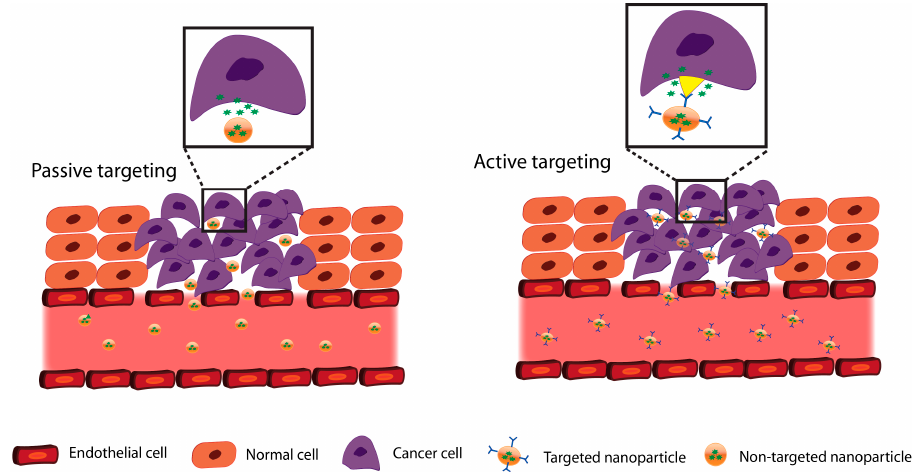
Figure 3. Tumor targeting approaches in oral drug delivery.